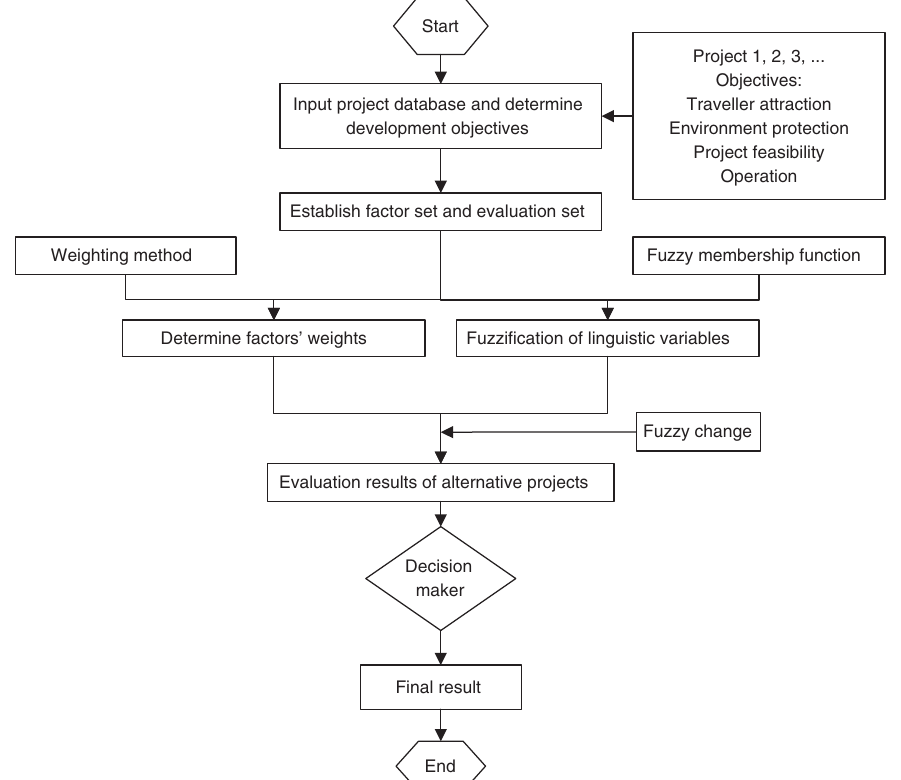
Fig. 1. Development process of the proposed